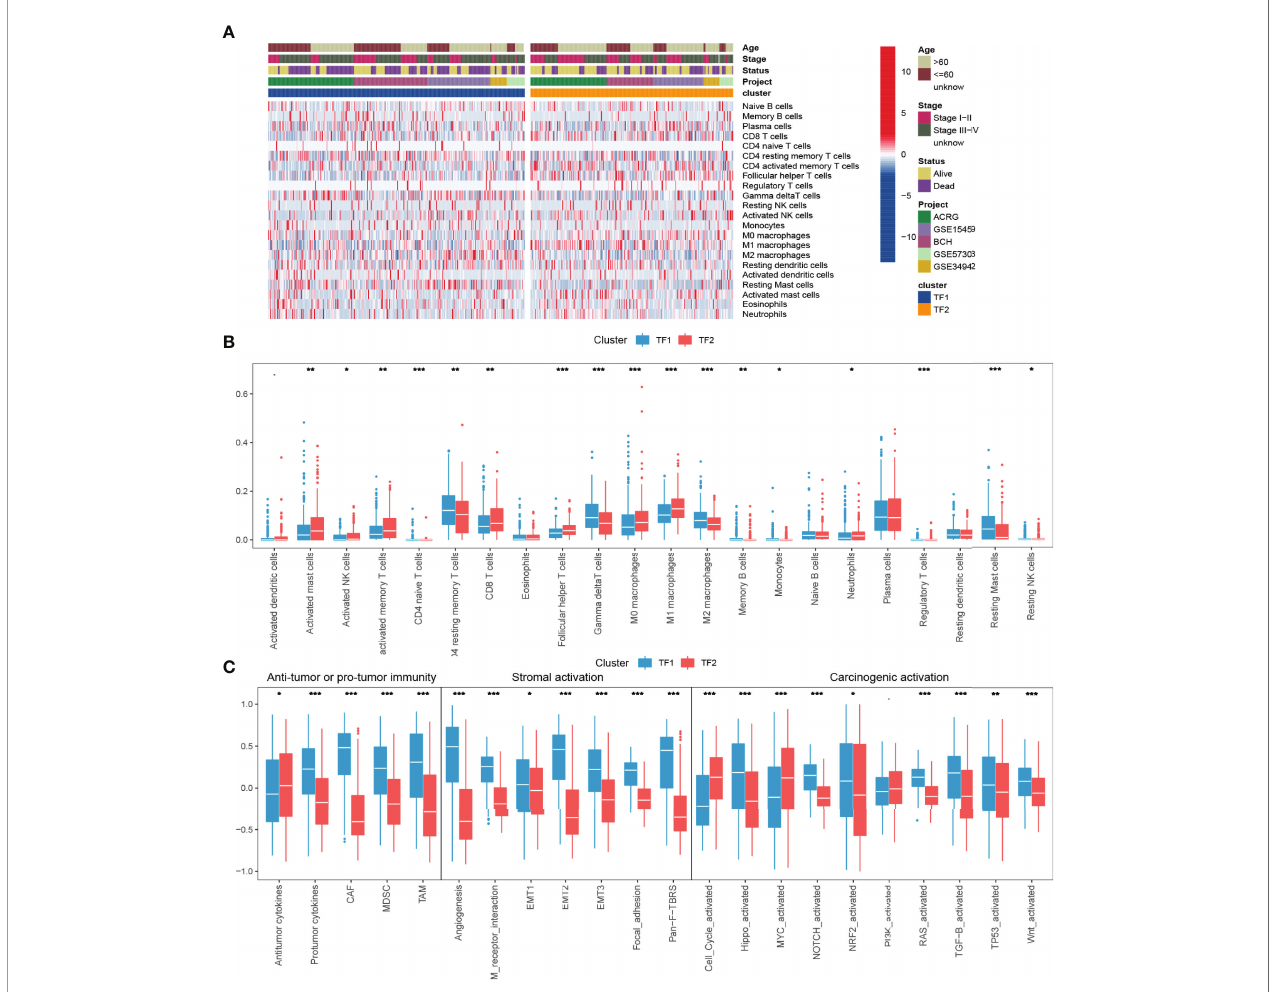
FIGURE 3 | TIME characteristics and transcriptome traits for distinct IRTF regulation patterns. (A) The distribution characteristics of 22 immune cells and clinical phenotypes for distinct IRTF regulation patterns. (B) A comparative analysis of the differences between 22 immune cell types for distinct IRTF regulation patterns. (C) The GSVA analysis showed differences in tumor immunity, stroma-activated pathways and common carcinogenic pathways. ***: < 0.001; **: < 0.01; *: <